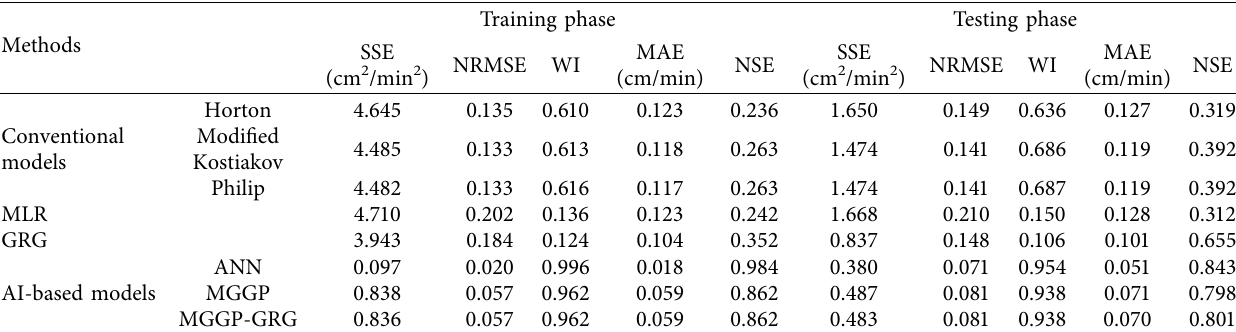
Table 3: Comparative statistics for fit of model to the observed infiltration